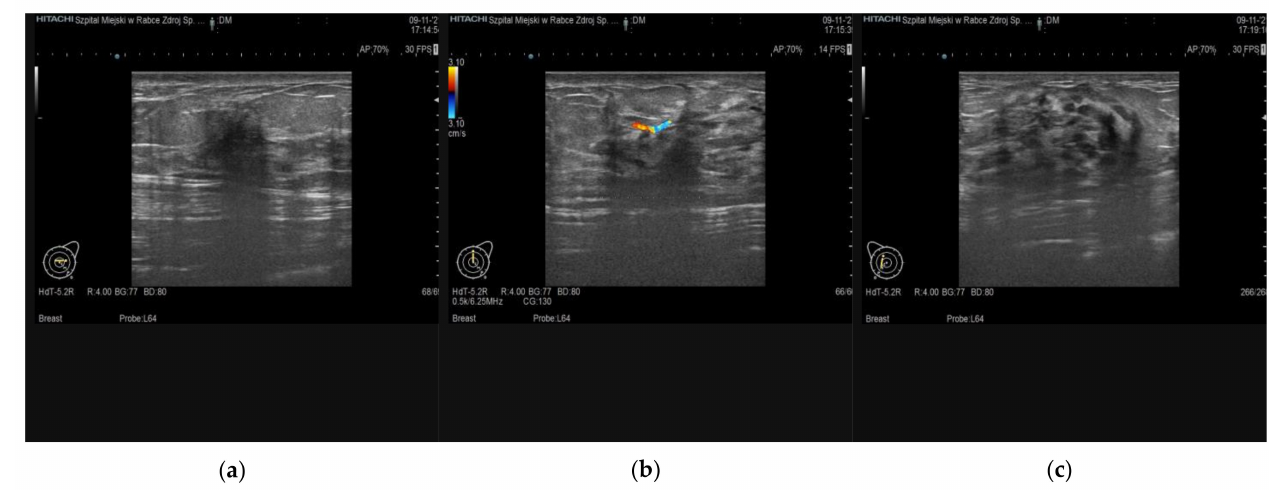
Figure 3. B-mode ultrasound of a 41-year-old female with type I diabetes mellitus and Hashimoto disease, positive family history of melanoma, diabetic mastopathy, and following core-needle biopsy: ( a ) 16 × 14 mm irregular, hypoechogenic lesion with blurred/spicular margins, BI-RADS-US class 4c ( b ) 18 × 6 mm irregular, hypoechogenic lesion with blurred/spicular margins, visible vascularity on color Doppler, BI-RADS-US class 4c ( c ) 25.7 × 20 mm oval shape breast lesion with parallel to the skin orientation, well-defined margins, heterogeneous echogenic structure and acoustic shadowing, BI-RADS-US class